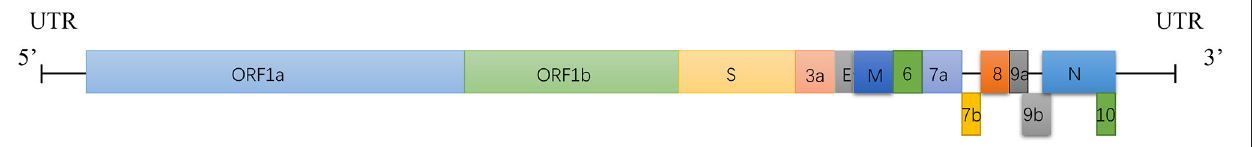
FIGURE 1 | The genome structure of SARS-CoV-2 viruses. The whole length of SARS-CoV-2 genome is nearly 30kb, with 11 ORFs and encoding 27 viral proteins. In general, SARS-CoV-2 genome is capped at the 5’UTR and polyadenylated at the 3’UTR. The S, E, M, and N genes encode structural proteins. While, ORF1a and ORF1b, occupying approximately the two-thirds of full-length genome, belong to the genes that encode non-structural proteins, containing nsp1 to nsp16. Also, the rest of the genes encode the accessory proteins. UTR, untranslated regions; ORFs, open reading frames; S, spike; E, envelope; M, membrane; N,